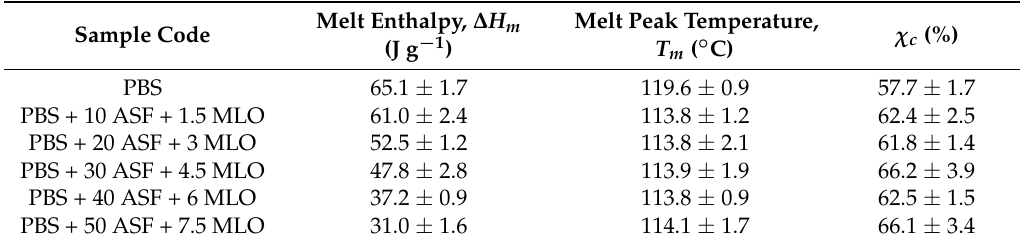
Table 3. Main thermal properties of PBS/ASF/MLO composites with varying ASF content, obtained by differential scanning calorimetry (DSC)